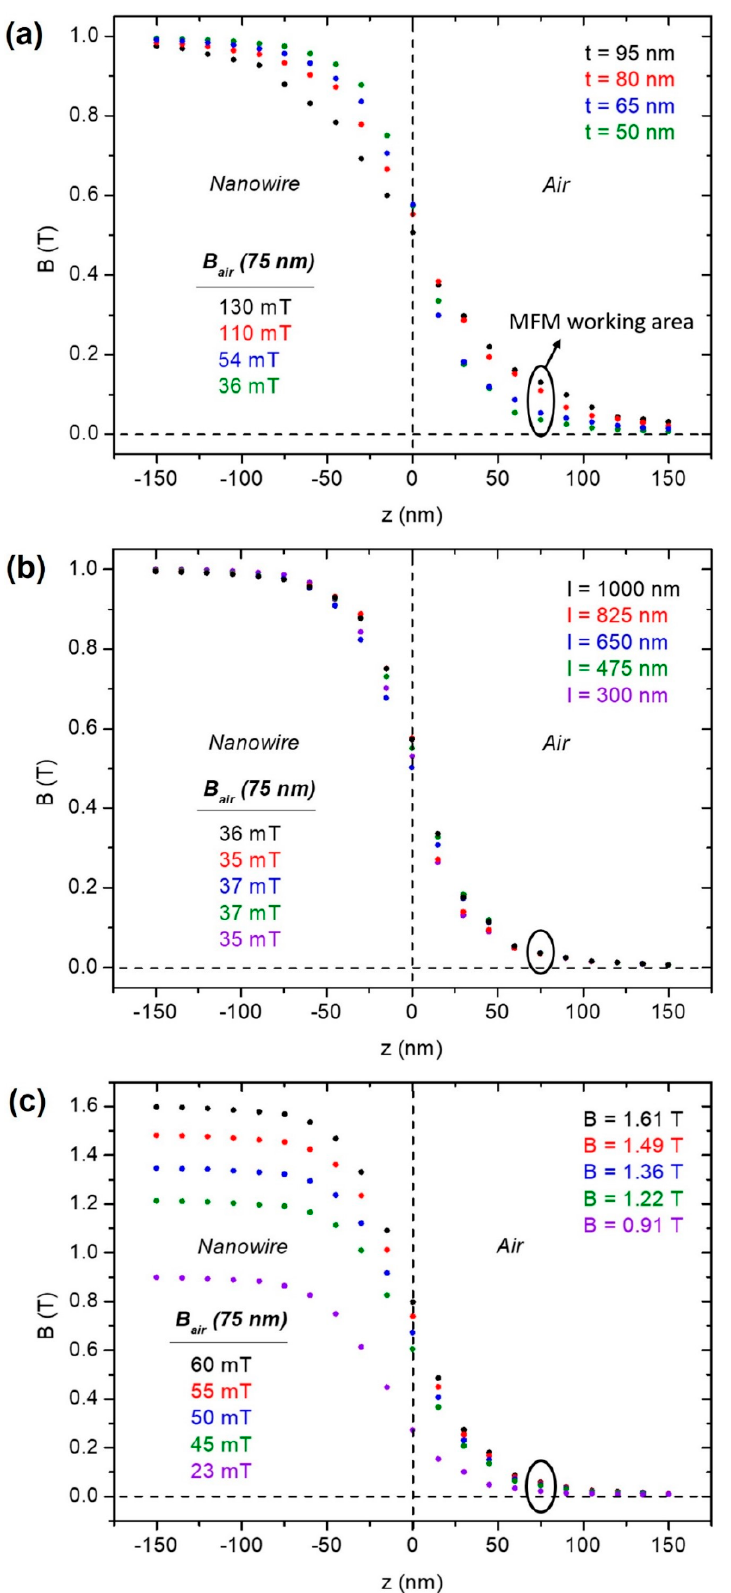
Figure 6. Calculation of the magnetization as a function of the distance to the apex along the nanowire longitudinal axis direction for different ( a ) diameter, ( b ) length, and ( c ) B values in the central region of the nanostructure. The QuickField software package was used. Reproduced from [61].